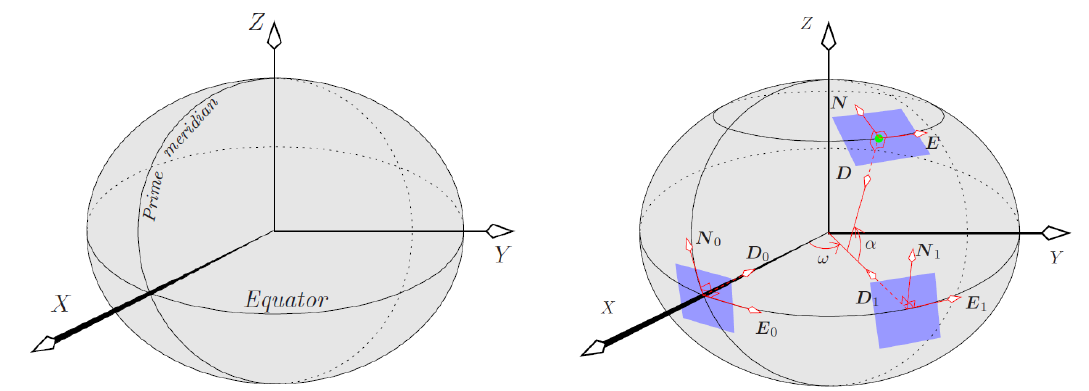
Figure 4. Geographic coordinate systems used: ECEF and NED